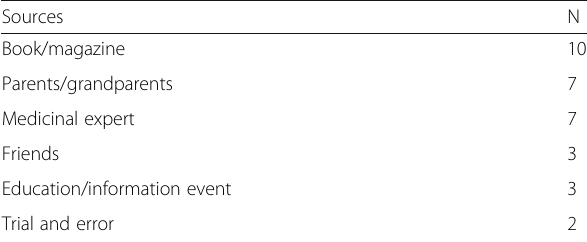
Table 4 Sources of Information. The numbers represent the absolute frequency of mentioning a specific information